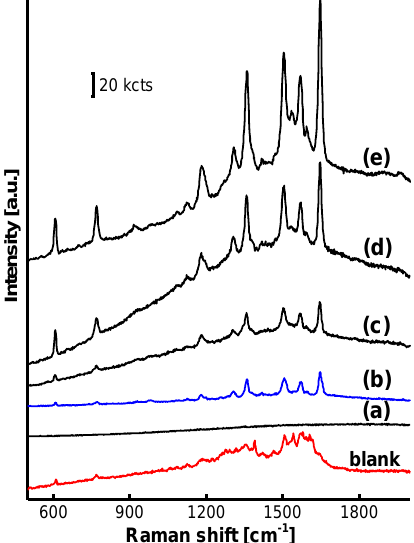
Figure 10. SERRS spectrum as a function of the R6G concentration on the optimized AgNP/MF 6 : ( a ) 1.0 × 10 − 15 , ( b ) 1.0 × 10 − 13 , ( c ) 1.0 × 10 − 11 , ( d ) 1.0 × 10 − 9 and ( e ) 1.0 × 10 − 7 M were R6G-SERRS spectra on the optimized AgNP/MF 6 treated with a R6G solution from 1.0 × 10 − 15 to 1.0 × 10 − 7 M R6G at a laser power of 0.01 mW and the SERRS detection was conducted on the blank AgNPs treated with 1.0 × 10 − 7 M R6G solution at a laser power of 0.05 mW. The R6G SERRS spectrum was still clear if the AgNP/MF 6 was treated with a 1.0 × 10 − 13 M R6G solution.